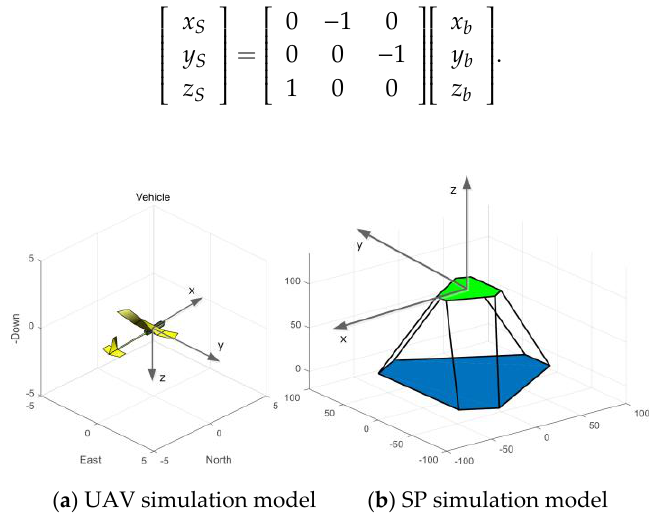
Figure 16. The coordinate system of SP and UAV.